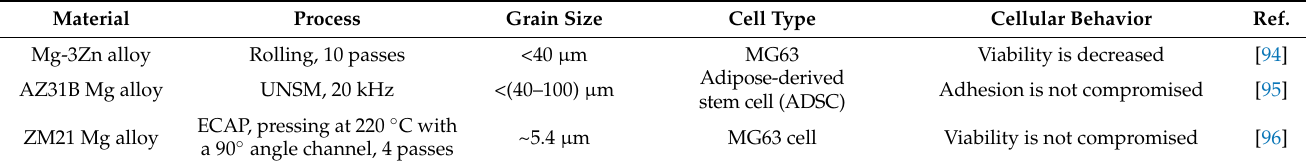
Table 5. Cell response to magnesium and its alloys after surface/bulk grain refinement.